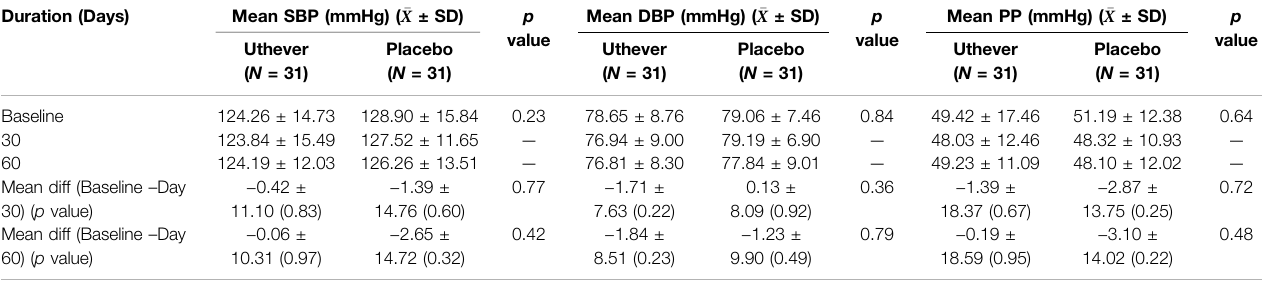
TABLE 5 | Comparison of changes in mean pulse pressure, systolic and diastolic blood pressure between the groups.